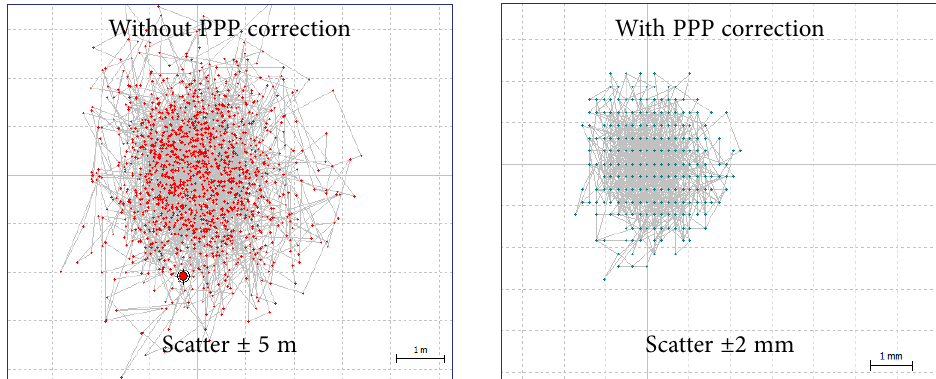
Fig. 6. Fixed point, before the PPP technique and after (source: figures made by the authors)